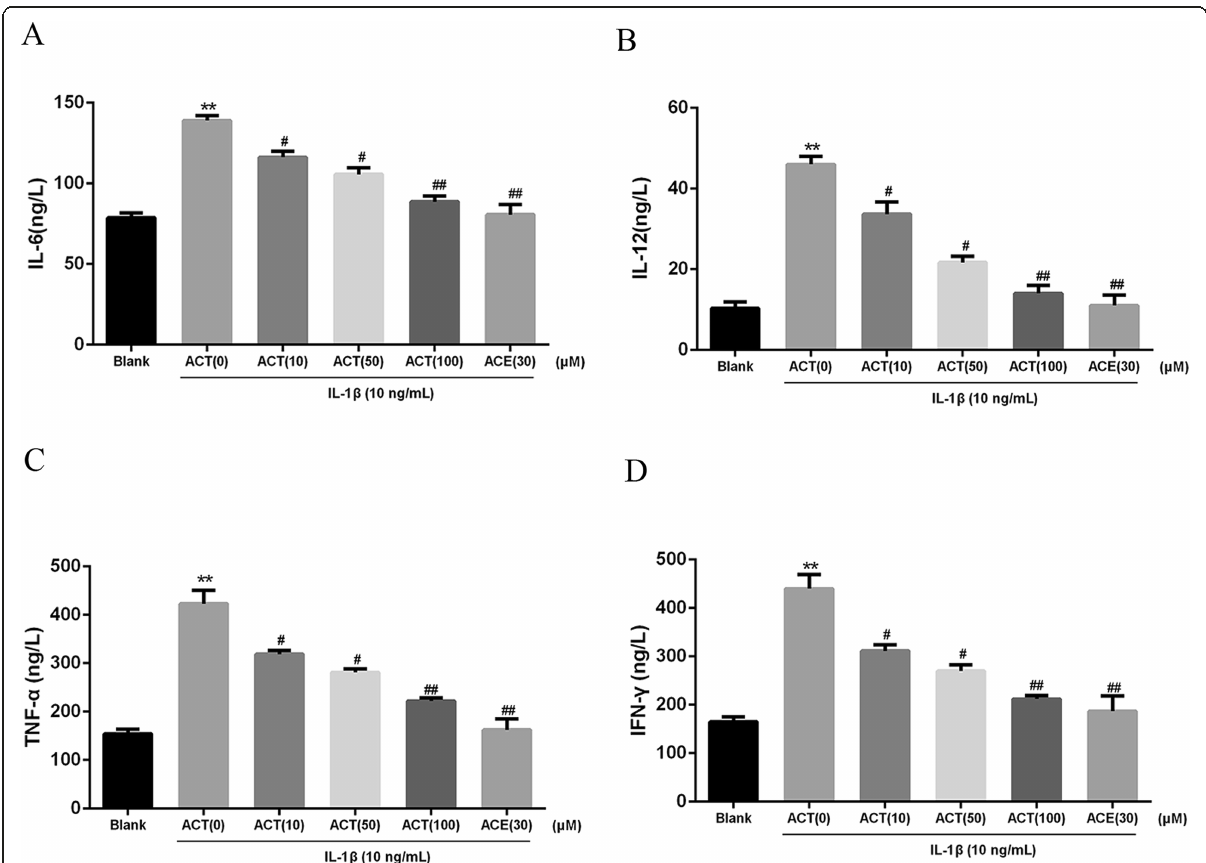
Fig. 2 ACT inhibits inflammatory cytokine production in primary chondrocytes induced by IL-1 β stimulation. Rat primary chondrocytes were untreated or treated with 10 ng/mL IL-1 β together with different concentration of ACT or ACE (positive control, 30 μ M) for 24 h. a - d The expression levels of IL-6, IL-12, TNF- α and IFN- γ in culture supernatants were measured by ELISA assay. *** p < 0.001, ** p < 0.01 and * p < 0.05 compared with blank group. ## p < 0.01 and # p < 0.05 compared with IL-1 β group. The experiment was repeated three times and